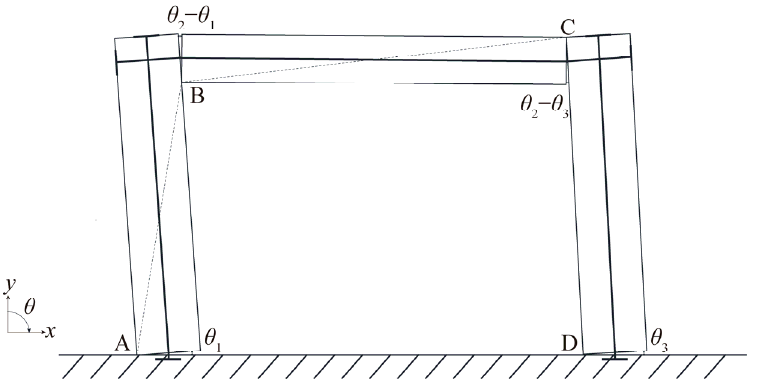
Figure 2. Rocking mechanism and planar four-bar linkage mechanism of PCRF during counterclockwise rotation.